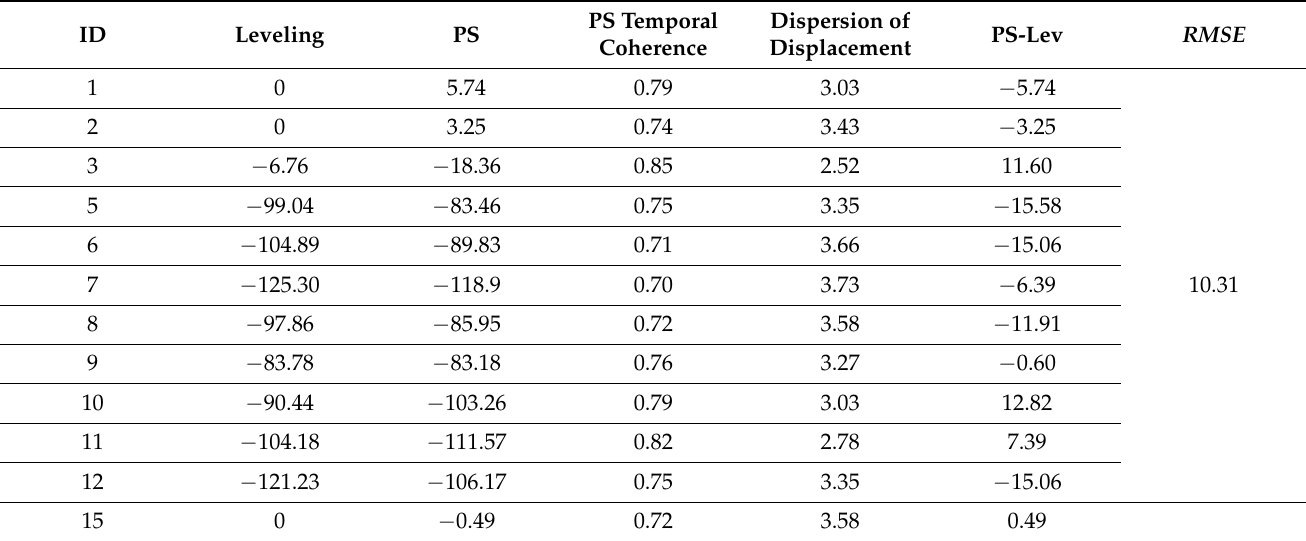
Table 3. Validation of an average displacement rate of PS results with leveling measurements (unit: